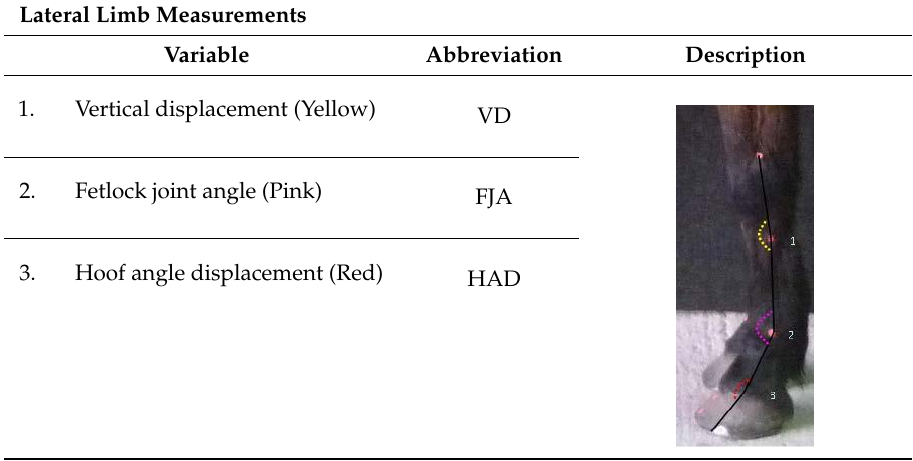
Table 4. Angular and linear morphometric variables measured from the 2D lateral view of the limb. Lateral limb measurements